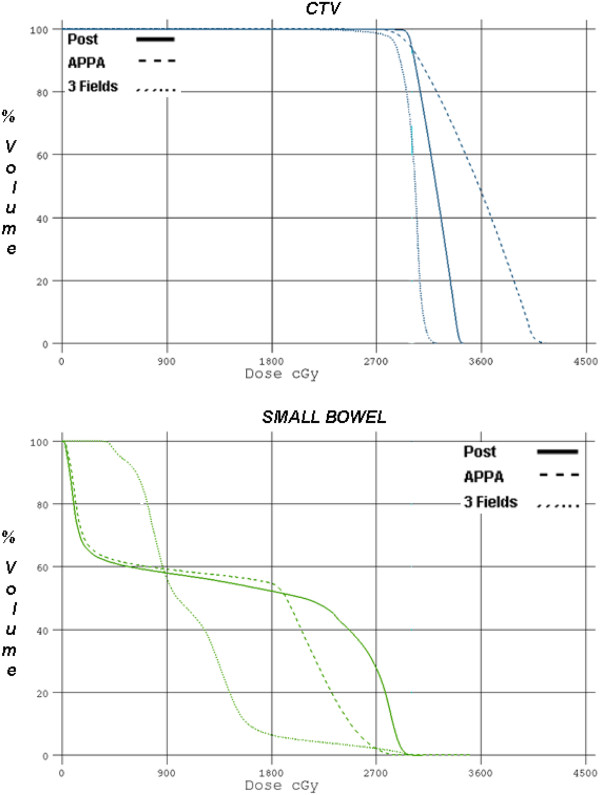
Dose volume histograms for PTV and bowel. It can be seen that the CTV coverage is similar for all 3 plans while there is improved bowel sparing in the 3D plan.